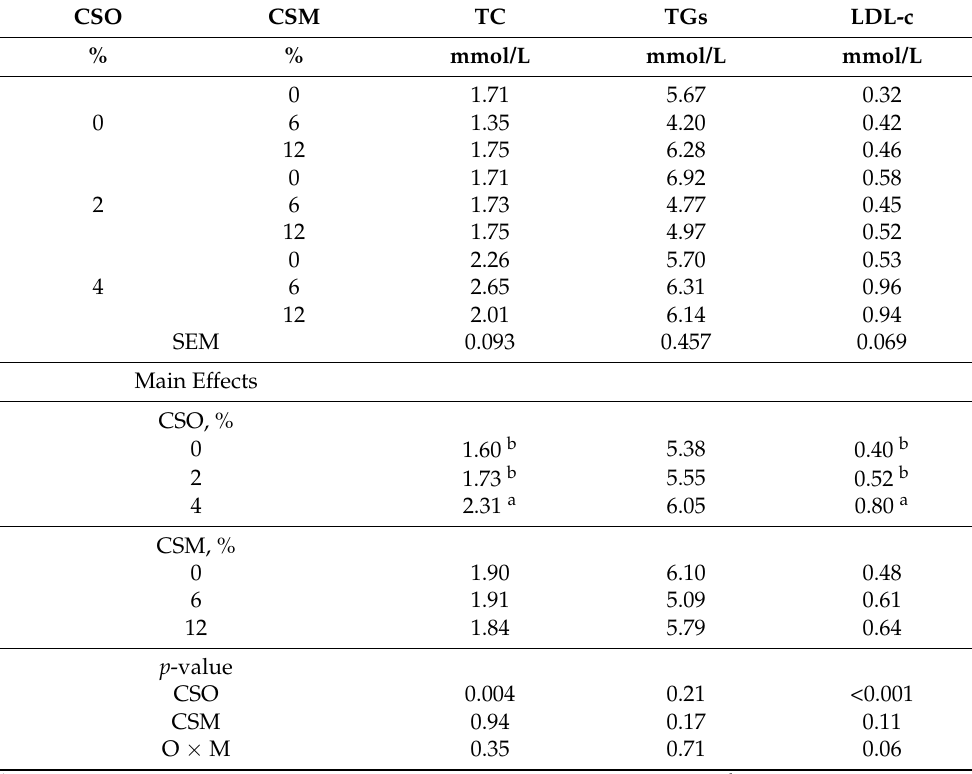
Table 6. Effects of cottonseed oil (CSO) and cottonseed meal (CSM) on serum lipids in laying hens 1 .